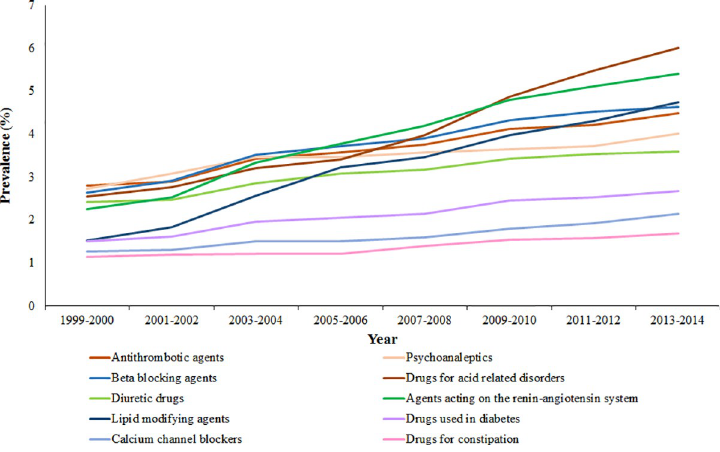
Fig 3. Prevalence of most commonly dispensed drug groups among adults in the Netherlands 1999–2014 (upward